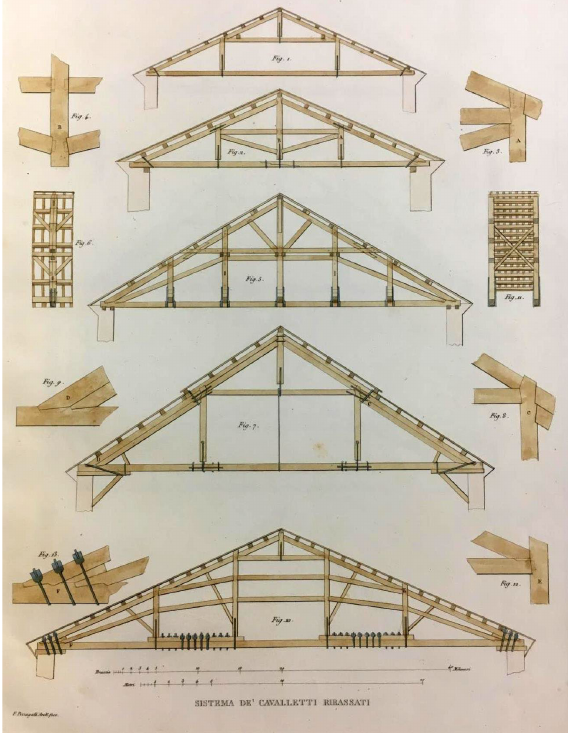
Figure 2: Pizzagalli & Aluisetti: Tav. XI, Wooden trestle